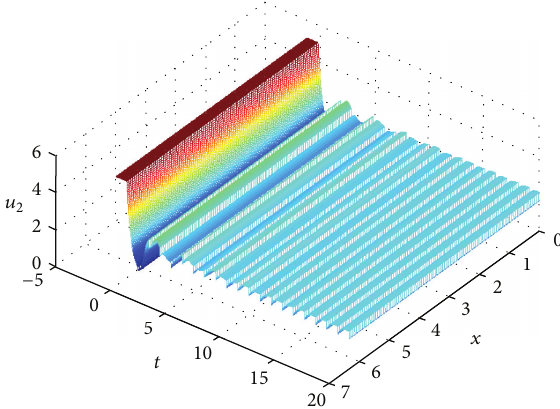
Figure 4: State response 𝑢2(𝑡,𝑥) of model (44) with impulsive